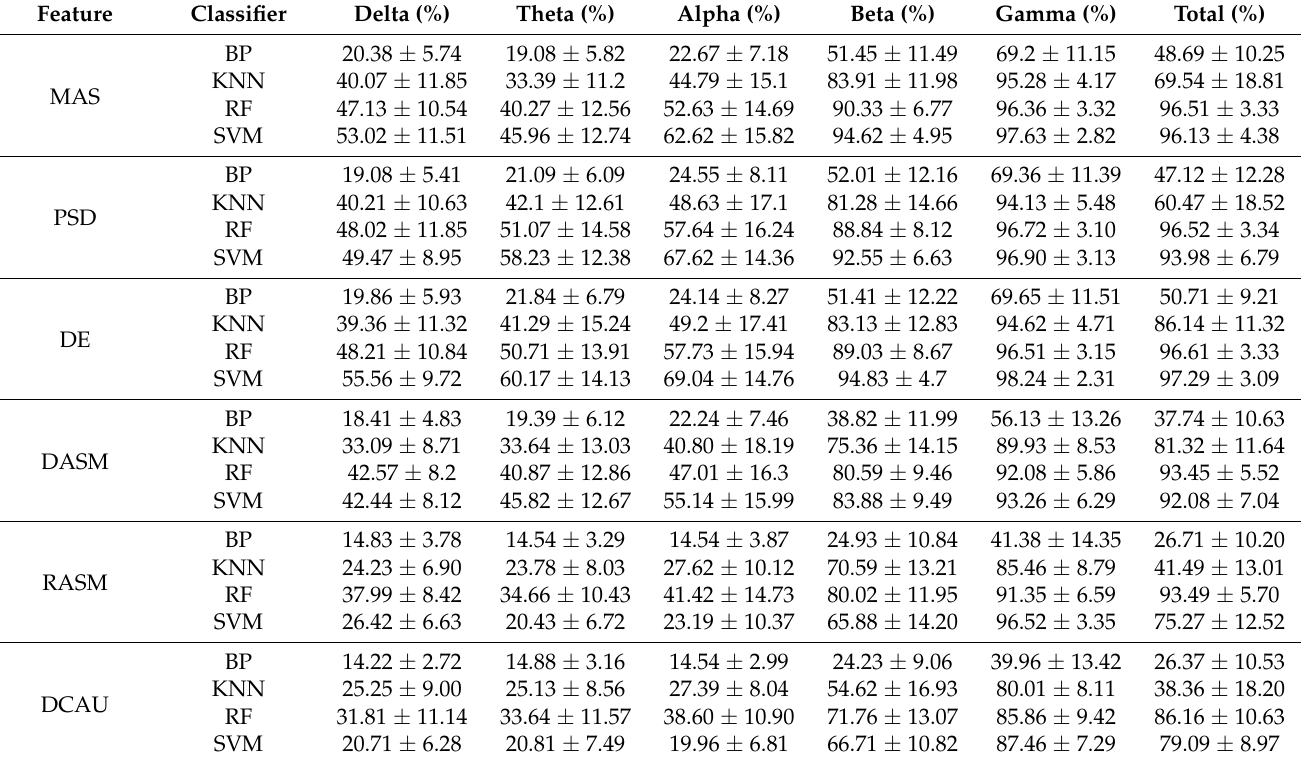
Table 2. The accuracy of landscape perception and recognition based on different EEG features and different classifiers.